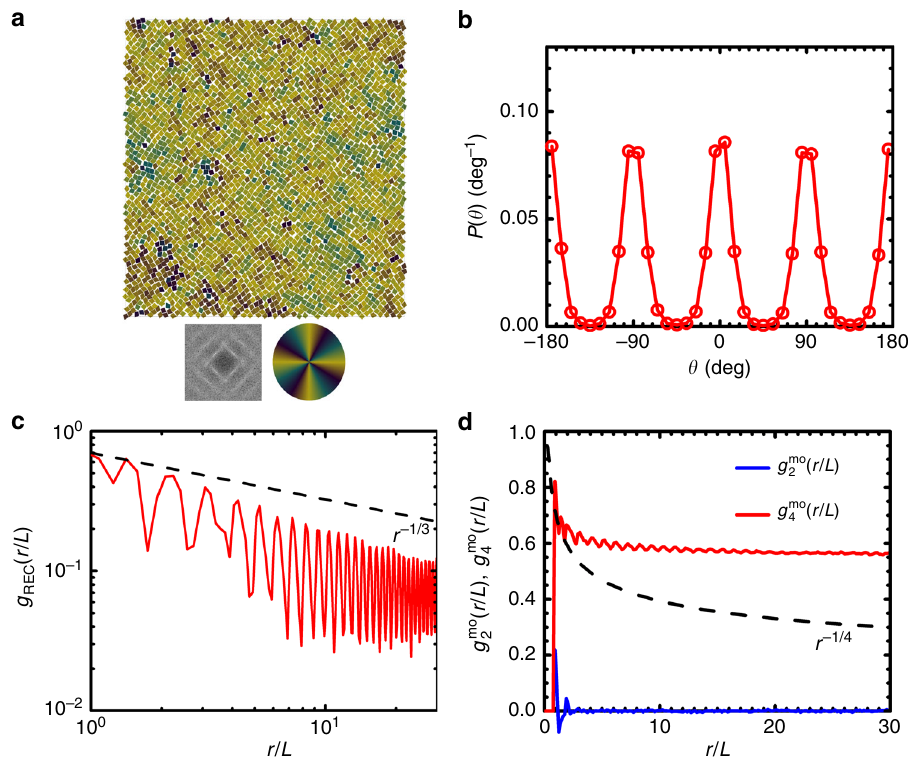
Fig. 3 An example of a T1 phase ( α = 90°, ϕ A = 0.774, NPT ensembles). a A color-coded con fi guration using a color wheel with fourfold rotational symmetry. Bottom left: the fast Fourier Transform (FFT); bottom right: color wheel used for color-coding particle orientations. b Probability density P ( θ ) of single-particle orientational angle θ . c The spatial correlation function of rectangular crystal lattice g REC ( r ). Dashed line is ∝ r − 1/3 . d Two- and fourfold molecular-orientational correlation functions: g 2 mo ( r/L ) and g 4 mo ( r / L ). Dashed line is ∝ r − 1/4